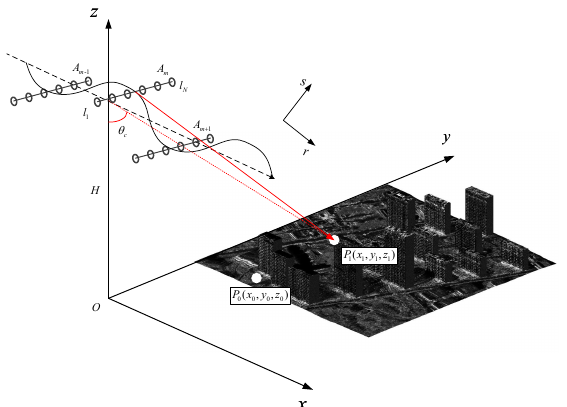
Figure 3. Geometric model of airborne array TomoSAR imaging under non-ideal trajectory.